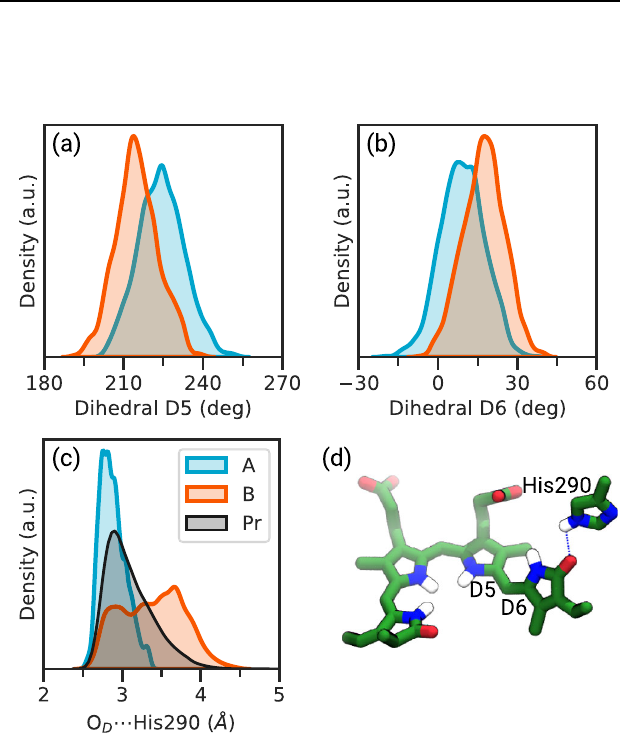
Fig. 2 | Comparison of ground-state QM/MM trajectories of the Pr state. a , b Distribution of the dihedrals D5 ( a ) and D6 ( b ) in the two sets of QM/MM-MD trajectories. c Distribution of the distance between D-ring carbonyl and His290 residueinthetwosetsofQM/MM-MDtrajectoriesandintherestingPrstate.ThePr distribution has been generated from a 4 μ s-long MM-MD simulation previously performed in our group 47 . d Representative structure of the BVin the Pr state with the His290 residue. Source data are available in the Zenodo repository 89